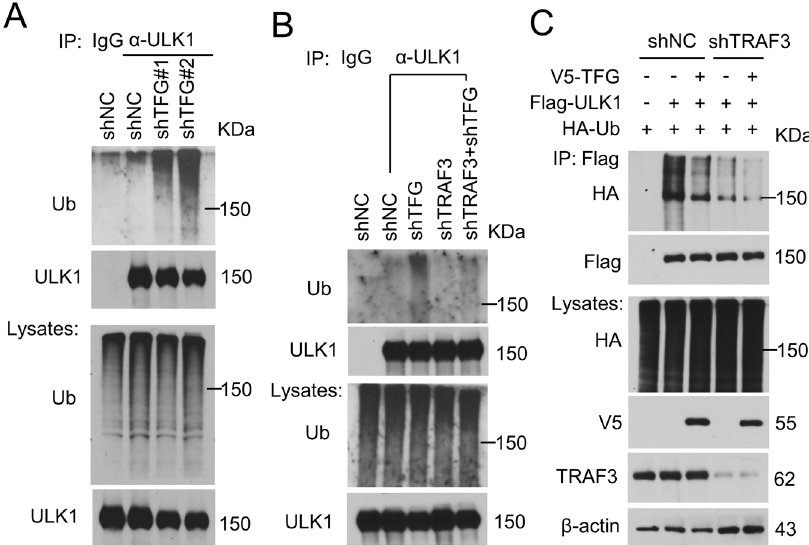
Fig. 3 TFG de fi ciency facilitates ULK1 ubiquitination and proteasome degradation. A THP-1 cells were transduced by shNC, shTFG#1, and shTFG#2 and treated with MG132 for 2 h before harvest. ULK1 was isolated by IP and subjected to IB assay using anti-ubiquitin (Ub) and anti- ULK1 antibodies. Whole-cell lysates were also subjected to direct IB (bottom panels). B THP-1 cells transduced with shNC, shTFG, shTRAF3, and shTFG + shTRAF3 were treated with MG132 for 2 h before harvest. ULK1 was isolated by IP and subjected to IB assays using anti-Ub and anti- ULK1 antibodies. C V5-TFG, Flag-ULK1, and HA-Ub were transfected into shNC- or shTRAF3-transduced HEK293 cells as indicated. Flag-ULK1 were isolated by IP and subjected to IB assays as indicated. Protein lysates were also subjected to direct IB (bottom panels). Experiments were independently repeated three